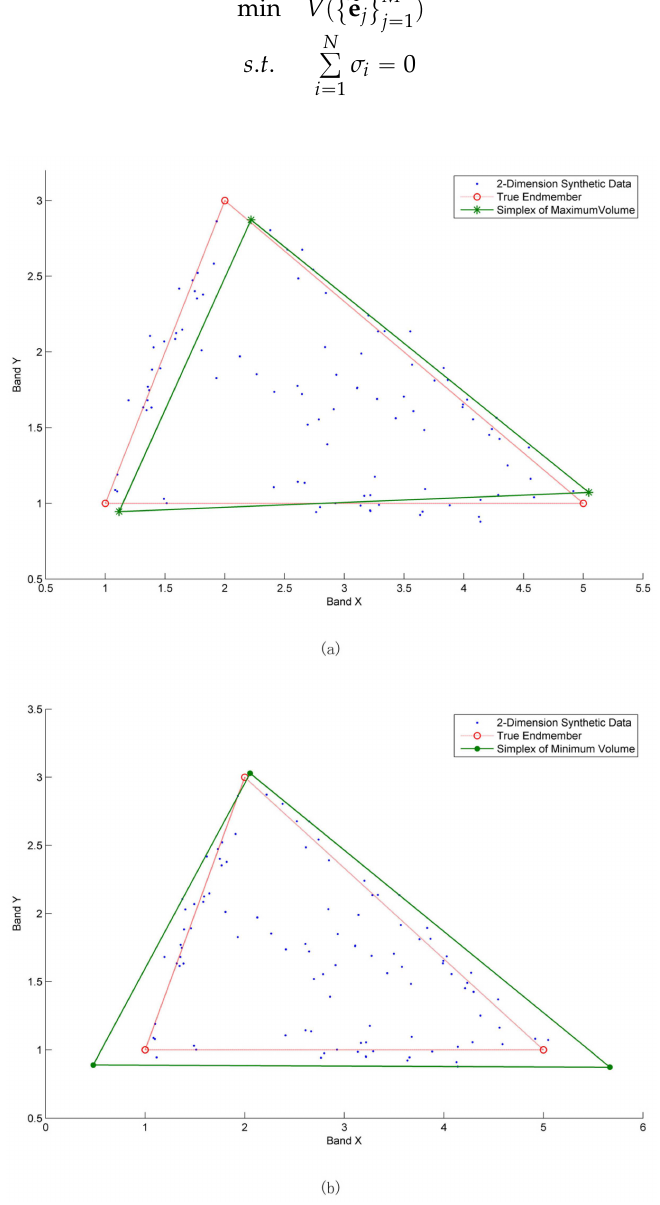
Figure 1. Sketches of the smallest simplex model ( a ) and largest simplex model ( b